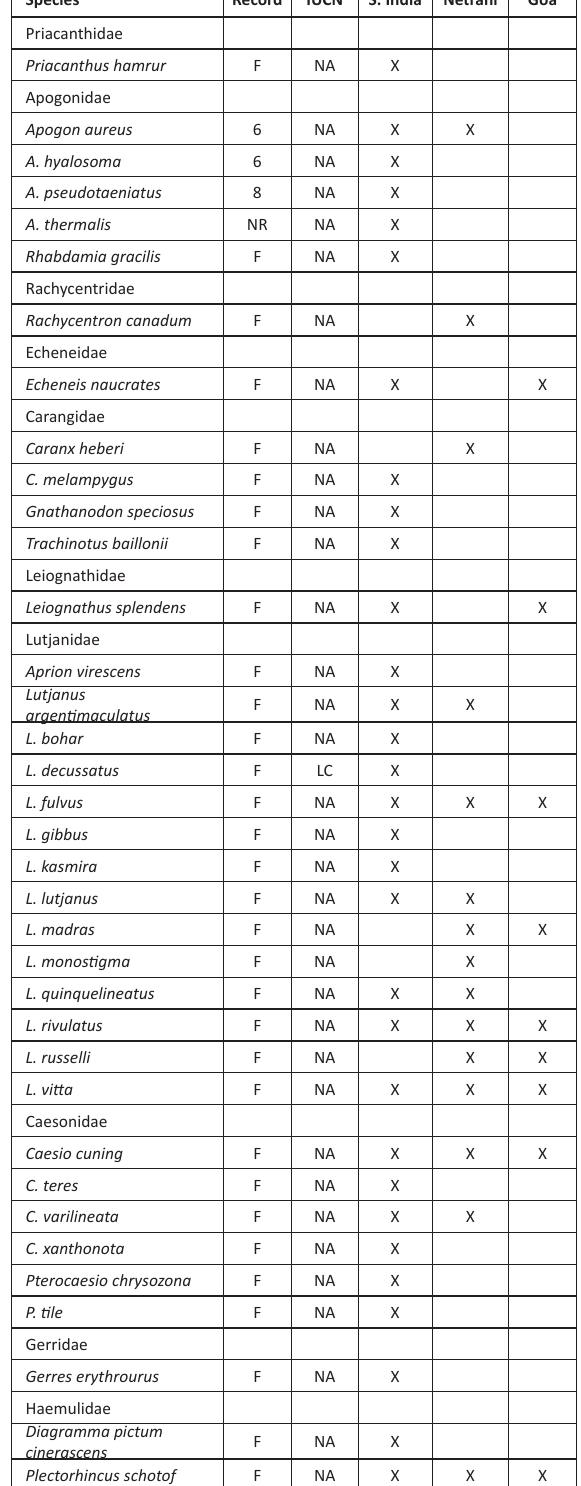
Table 1. Fish species observed in nearshore rocky/coral habitats of western India. An F in the Records column indicates this species recorded as present in India by the Fishbase database (www.fishbase.org) as of 26 April 2012. other references which establish fish distribution records for India are given below the table. Data with NR in the records column indicate new records for India (n=12). IUCN status is given as LC = Least Concern, DD = Data Deficient, NT = Near Threatened, VU = Vulnerable, EN = Endangered, and NA = Not Assessed.